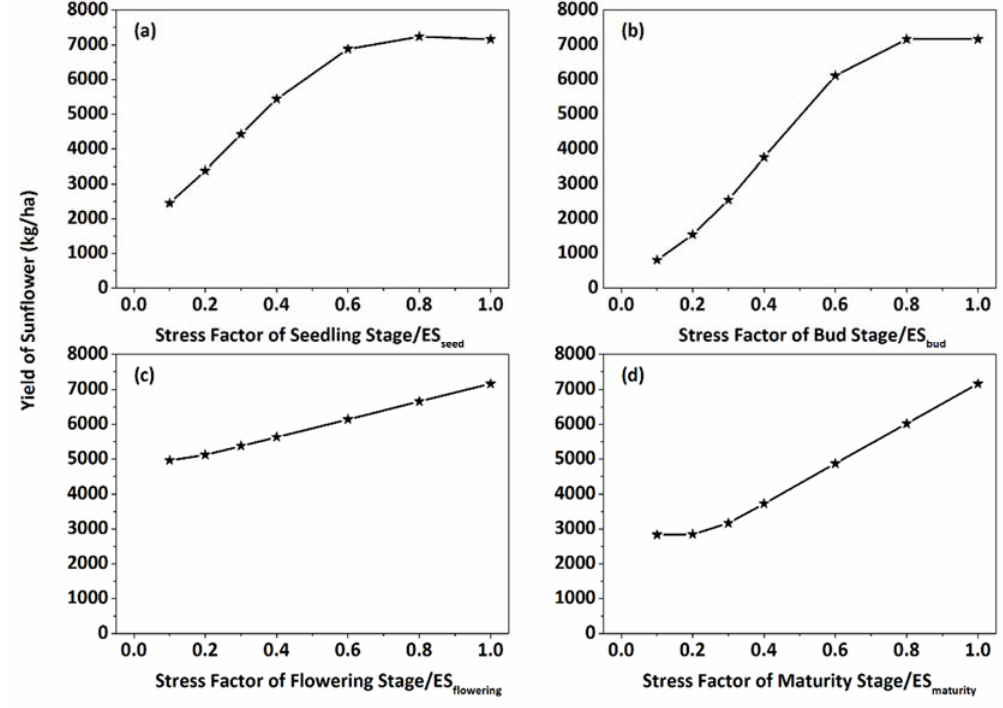
Figure 10. Change in yield with stress factors in the seedling ( a ), bud ( b ), flowering ( c ), and maturity ( d ) stages in 2012. ESs in the bud ( ES bud ) and flowering ( ES flowering ) stages were smaller than the combined water and salt stresses of the Feddes ‐ type stress reduction functions (Feddes ‐ WS), which indicated that stress